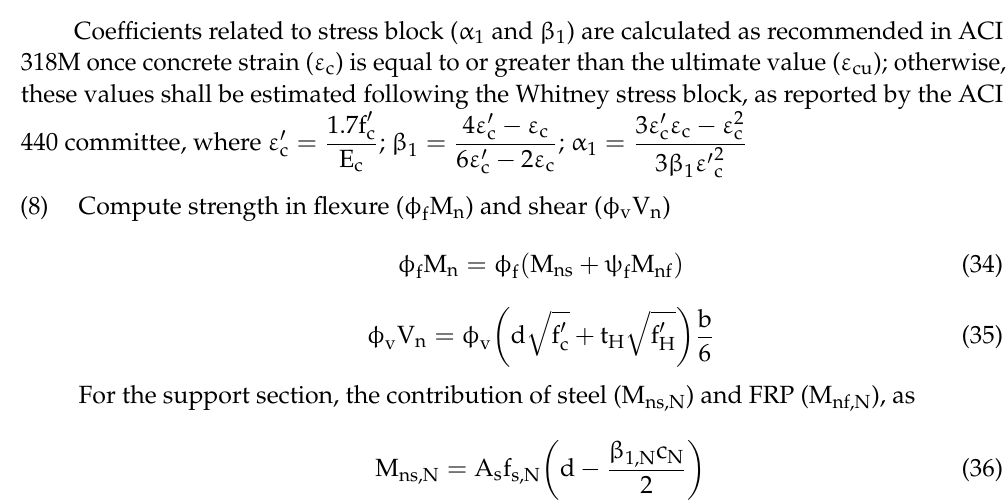
Figure 4. Retrofitting mechanism for a retrofitted slab ( a ) positive-moment section; ( b ) negative moment section.